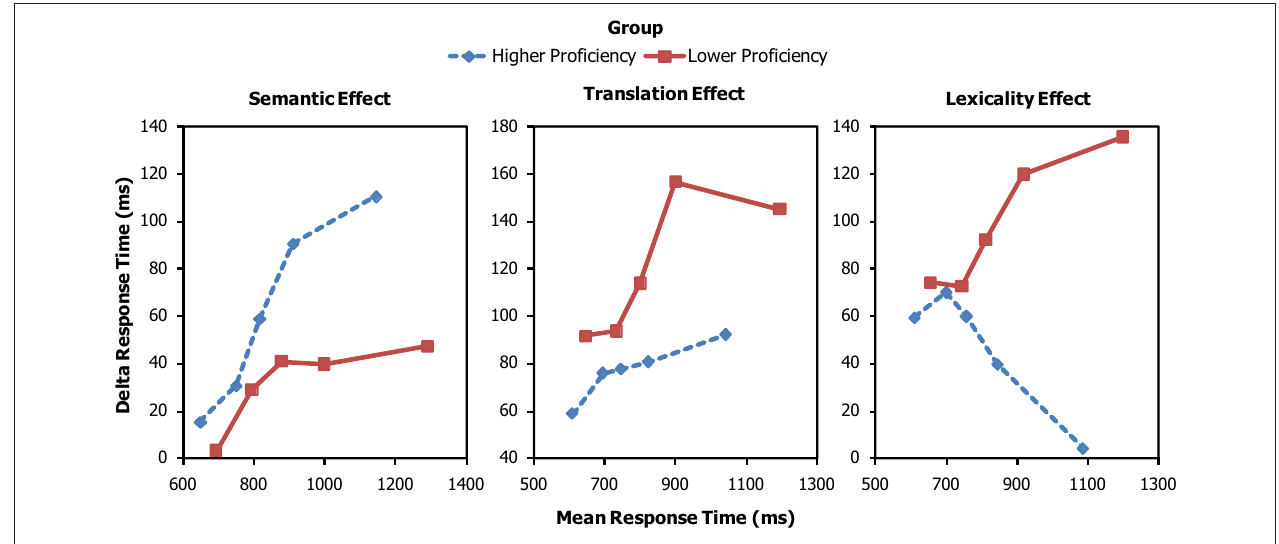
Figure 3 | Delta plots for the semantic, translation, and lexicality effects as a function of higher and lower proficiency. The response time values on the horizontal axis for the delta plots are the means of the response times in the two conditions used to compute each